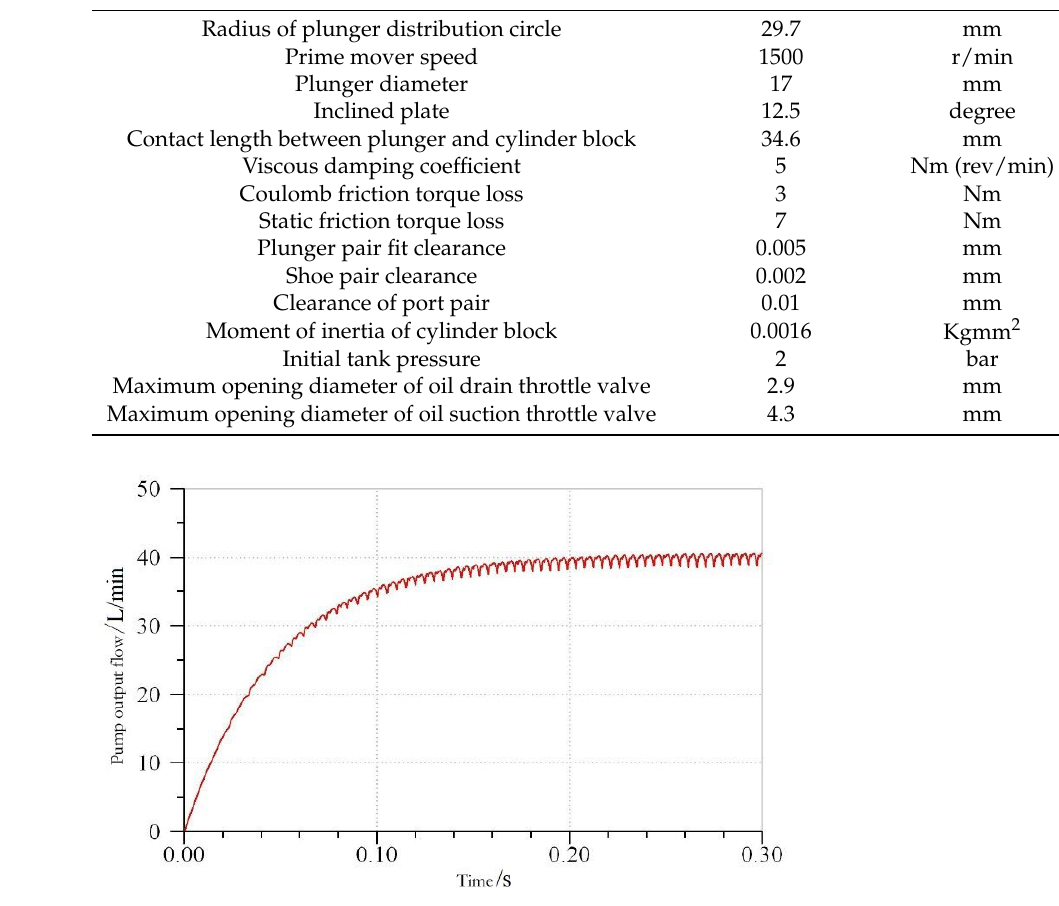
Figure 14. Output flow rate of axial piston pump.